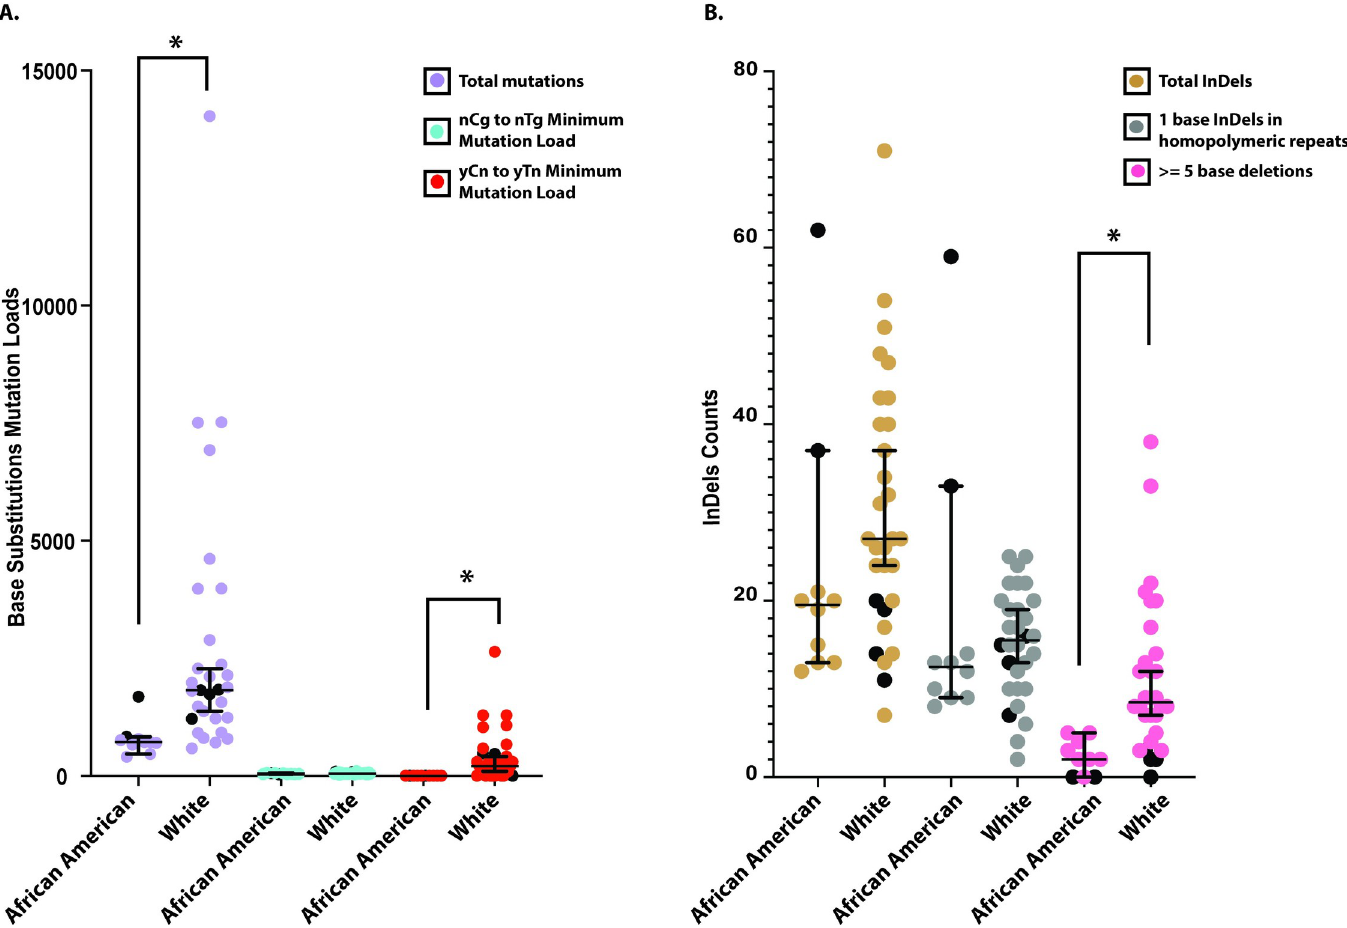
Fig 4. Base substitutions and indels in African American and White donors. (A) The total number of base substitutions, the nCg ➔ nTg minimum mutation load and the yCn ➔ yTn minimum mutation load in African American and White donors. Melanocytes are depicted as filled black circles. (B) The total number of indels, single nucleotide indels in homopolymeric repeats and deletions spanning five bases or more in the African American and White donors. Melanocytes are depicted as filled black circles. A two-sided Mann-Whitney U-test was performed to compare the mutation load across the two cohorts. � denotes a Bonferroni corrected P-value < 0.05. The source data for this figure is in S10